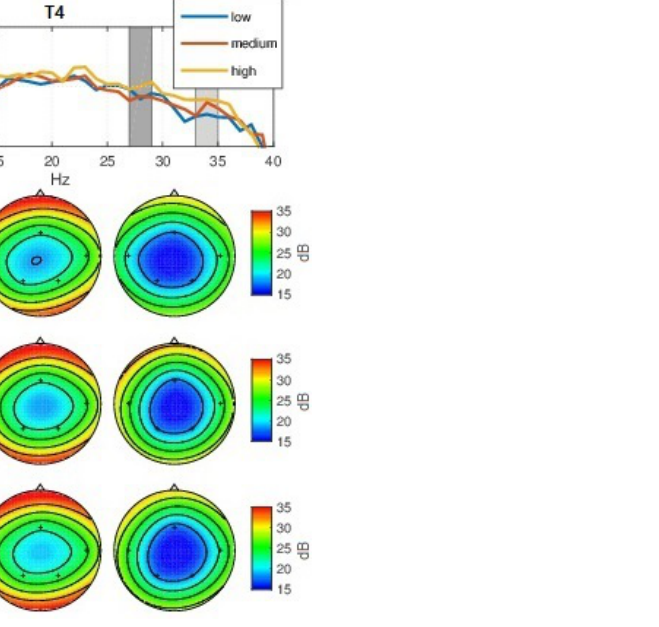
Figure 9. GA Spectrum for Nat images on three complexity levels according to CE, at the T4